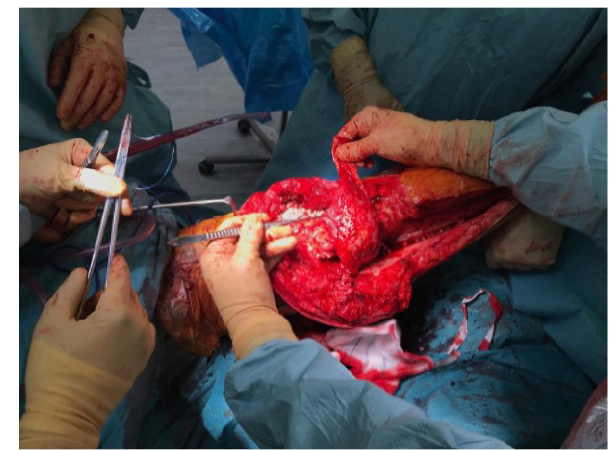
Figure 3. Inlay of the flap to cover the soft-tissue defect.